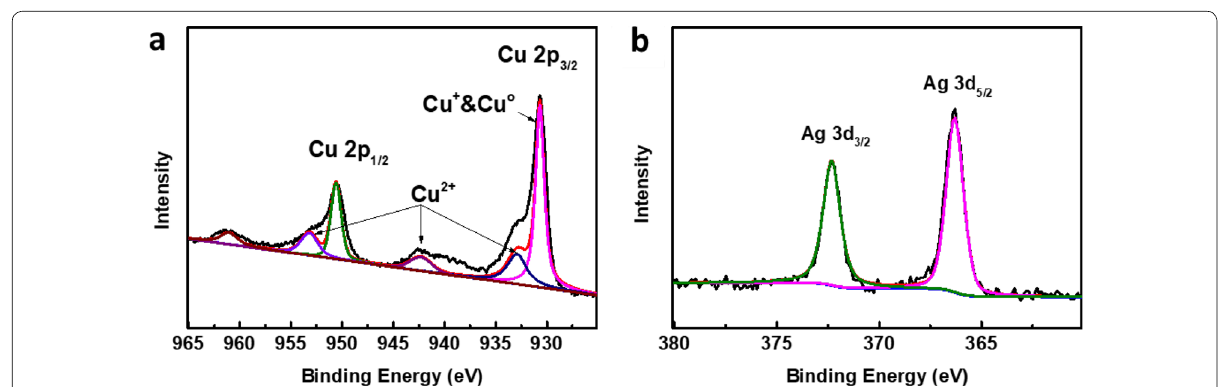
Fig. 2 XPS spectrum of Cu‑Ag‑Pt–Pd nanoparticles ( a ) Cu and ( b )